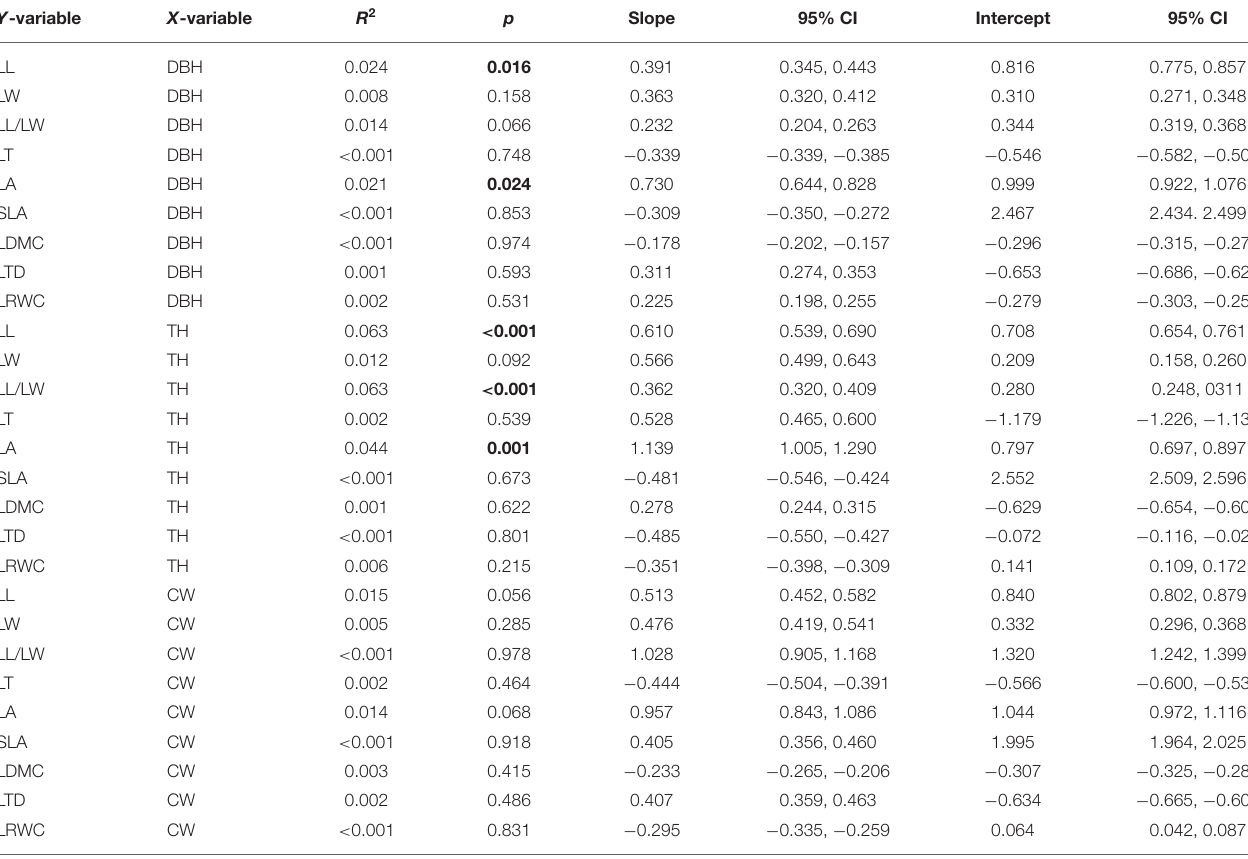
TABLE 1 | Allometric relationships between leaf structural traits and plant size factors. Y -variable